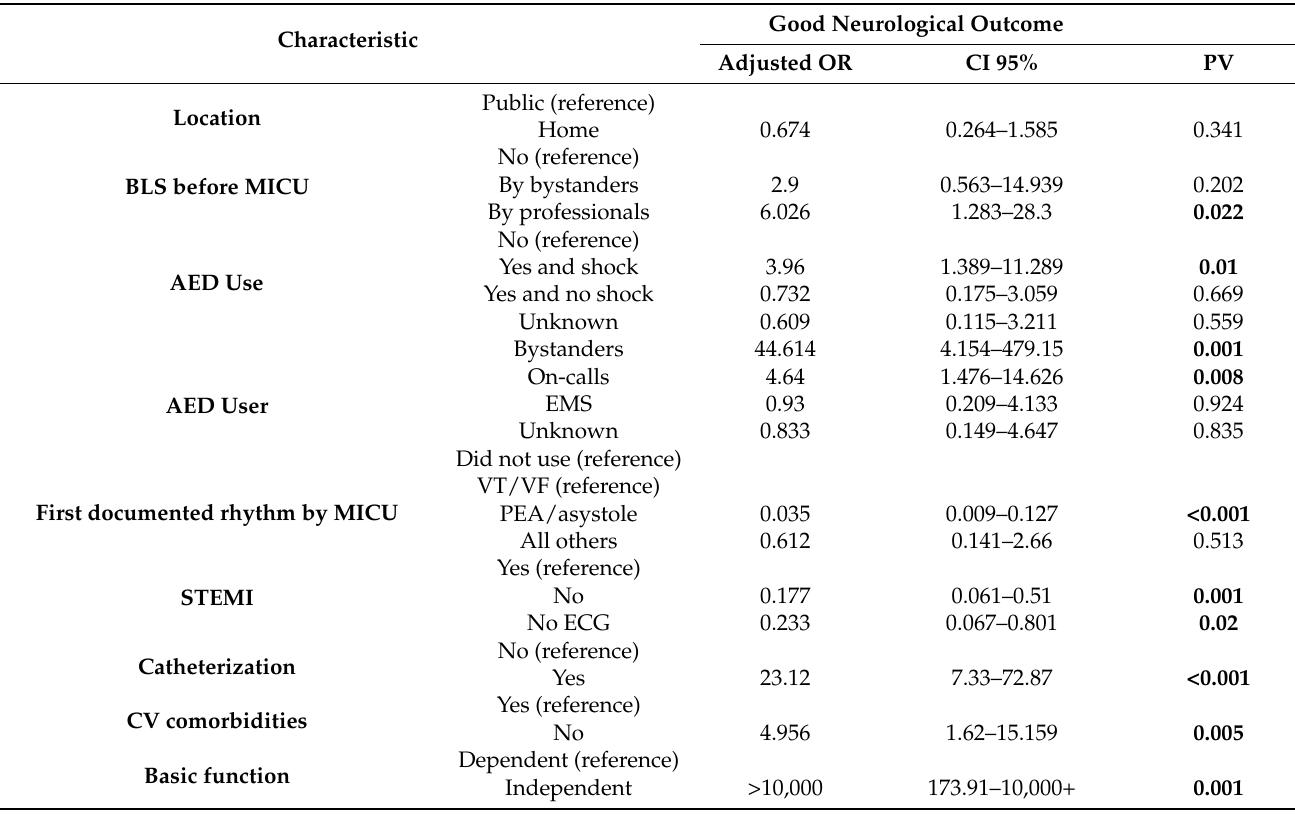
Table 6. Adjusted neurological outcome according to patients’ characteristics and prehospital and hospital care.